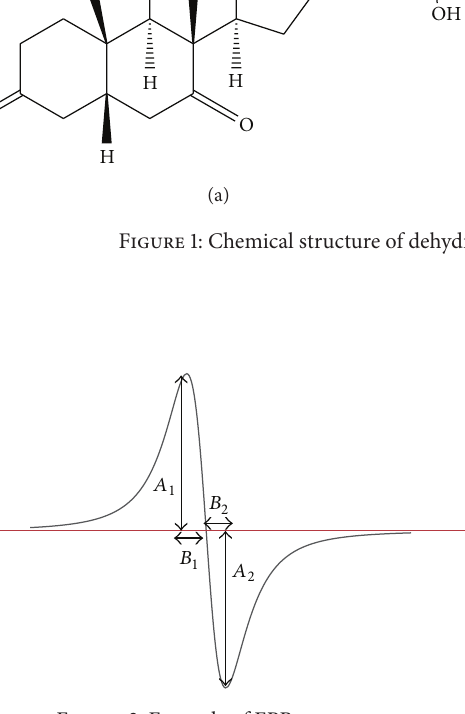
Figure 2: Example of EPR